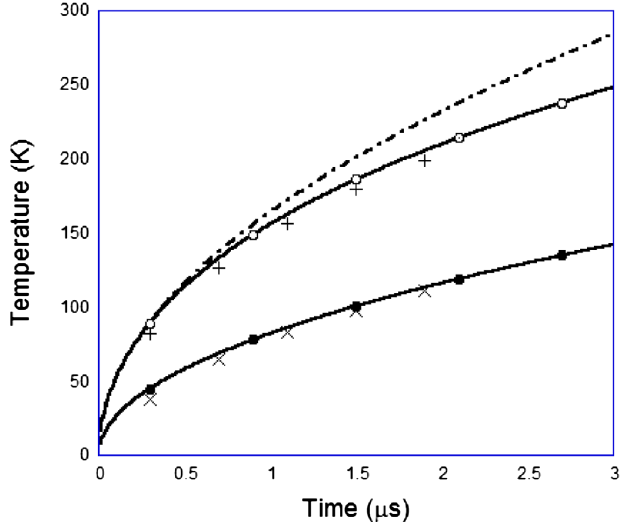
FIG. 5. Temperature rise vs time from calculation and simula- tion results: the solid curve with closed symbols represents the temperature rise at the infinite surface of a plane, the dashed curve twice that value, and the solid curve with open symbols represents the temperature rise at the crack upper corners. Cross marks along both solid curves are simulation results from ANSYS [16].